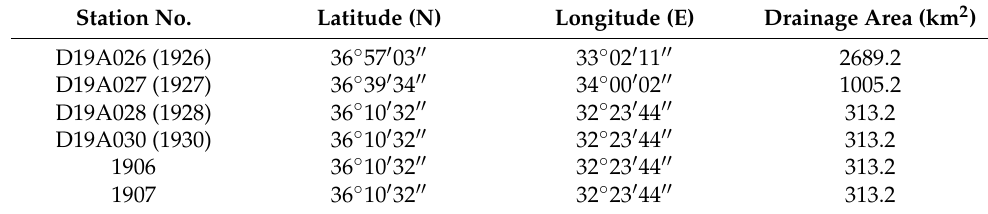
Table 1. SGSs general information [33].